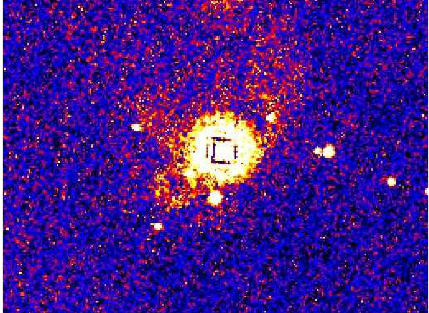
Figure 2: The Swift UVOT image of BZ Cam,